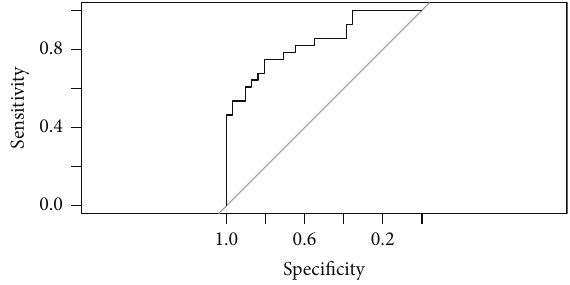
Figure 7: ROC curve for model MOD-C2.